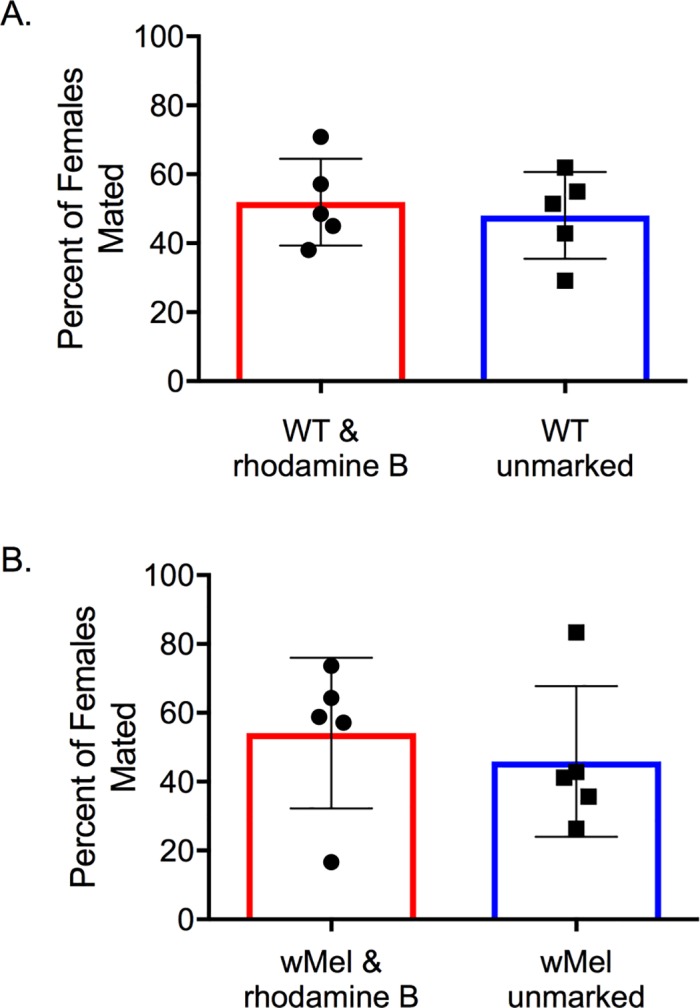
Mating competitiveness of rhodamine B marked males.Results of mating competitiveness assays represented as the percent (mean±SE) of females mated by (A) wild type and (B) wMel marked Ae. aegypti males vs. unmarked controls. Columns represent treatment means and points represent observations from individual replicates during which 80 virgin females (3–5 d old) were introduced to and kept in the presence of 40 virgin marked and 40 unmarked males (4–5 d old) in a semi-field cage for 72 h.